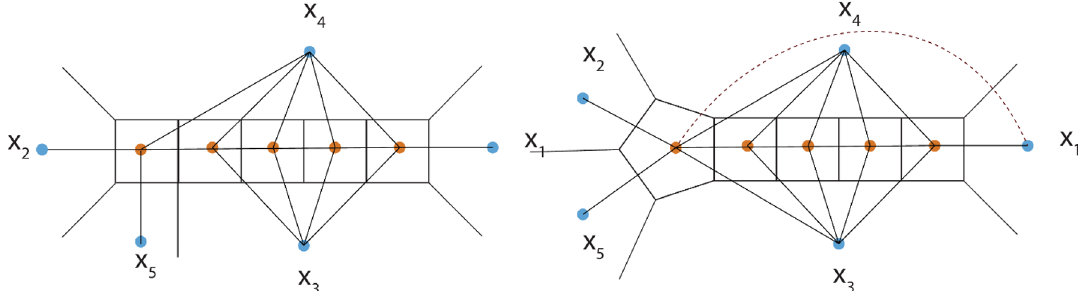
Figure 12 . Both position and momentum space representation of the ladder integral with 5 points are represented on the left. On the right there is the analogue for the pentaladder integral. The dashed line represents a